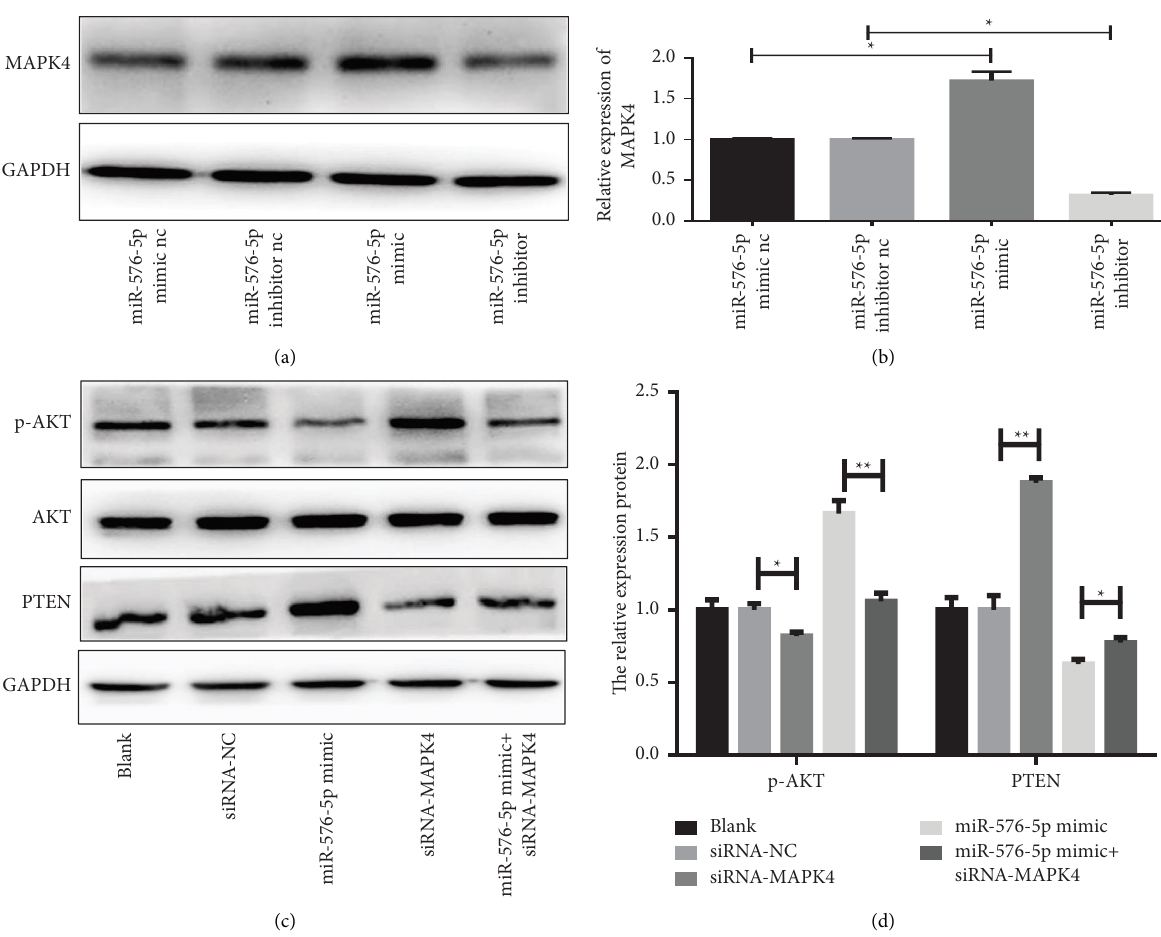
Figure 6: miR-576-5p promoted activation of MAPK4-AKTpathways in TPC-1 cells. (a–d) Protein expression levels of MAPK4 and PTEN/ p-AKT were detected by western blotting. ∗ P < 0 . 05 ; ∗∗ P < 0 .